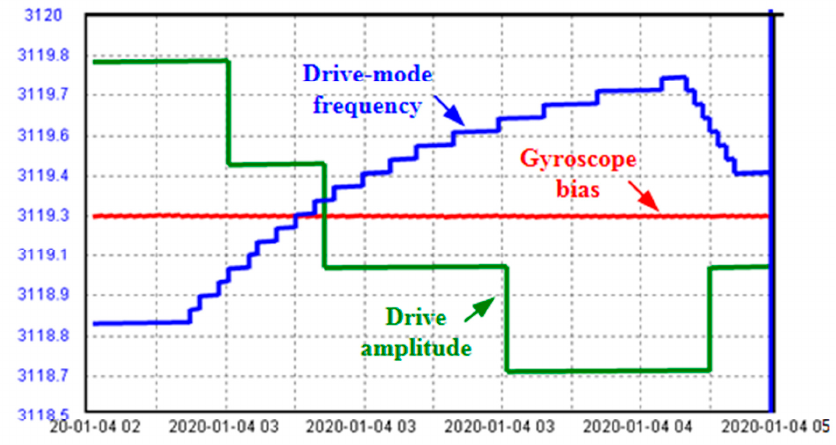
Figure 9. On-orbit data of the MEMS